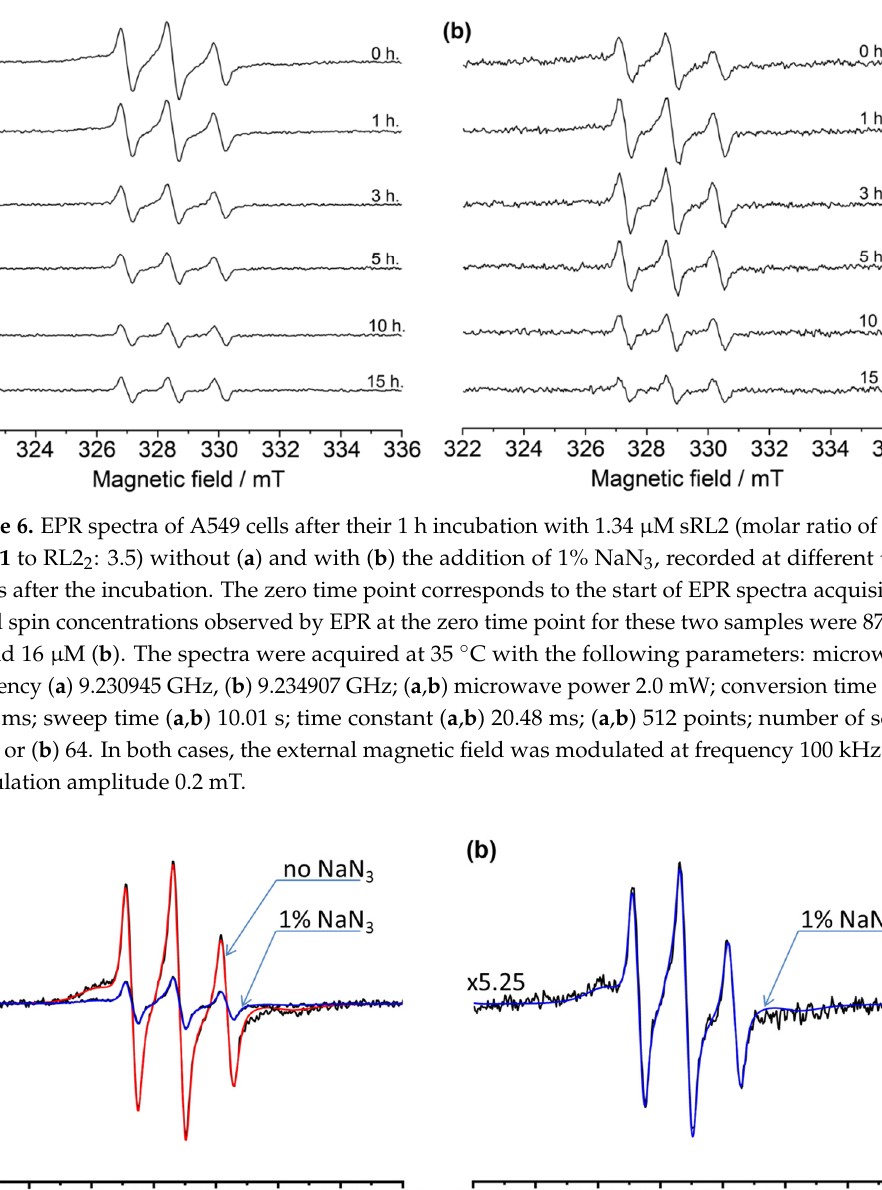
11 of 20 Figure 5. Localization of the fluorescent RL2 2 conjugate (fRL2) in A549 cells. ( a ) The microscopy analysis. Scale bar, 20 μ m. Regions of the intranuclear localization of Hoechst 33342 are blue, re- gions of fRL2 localization are red, lysosomes and endosomes with pH below 5.5 are green. ( b ) Colocalization analysis (Table S2). Orange lines denote cell edges and nuclei, green lines indicate lysosome and endosome edges, and red signals are fRL2 localization. 3.6. The Influence of Sodium Azide on the Penetration of sRL2 into A549 Cells Sodium azide (NaN 3 ) is known to inhibit ATP synthesis and thus inhibit endocytosis because endocytosis is an ATP-dependent process [61]. We studied the influence of so- dium azide on the penetration of sRL2 into A549 cells. In two independent experiments, cells were incubated in the culture medium containing sRL2 at 1.34 μ M (nitroxide con- centration 4.69 μ M) with and without the addition of 1% NaN 3 . In both cases, after 1 h of cell incubation, the cells were washed according to the procedure described in Methods. EPR spectra of all the solutions that were used to wash out the cells and the culture me- dium with dissolved sRL2 before and after the cells’ incubation are presented in Figures S12–S14. In the two experiments with and without the addition of NaN 3 , the samples contained either 3 μ L of a cell suspension with 8 μ L of the medium or 10 μ L of a cell suspension with 9 μ L of the medium, respectively, to increase the cell viability during the EPR experiments (see Section 3.8). EPR spectra of A549 cells at different time points after the cell incubation with 1.34 μ M sRL2 without and with 1% NaN 3 are presented in Figure 6a,b, respectively. One can